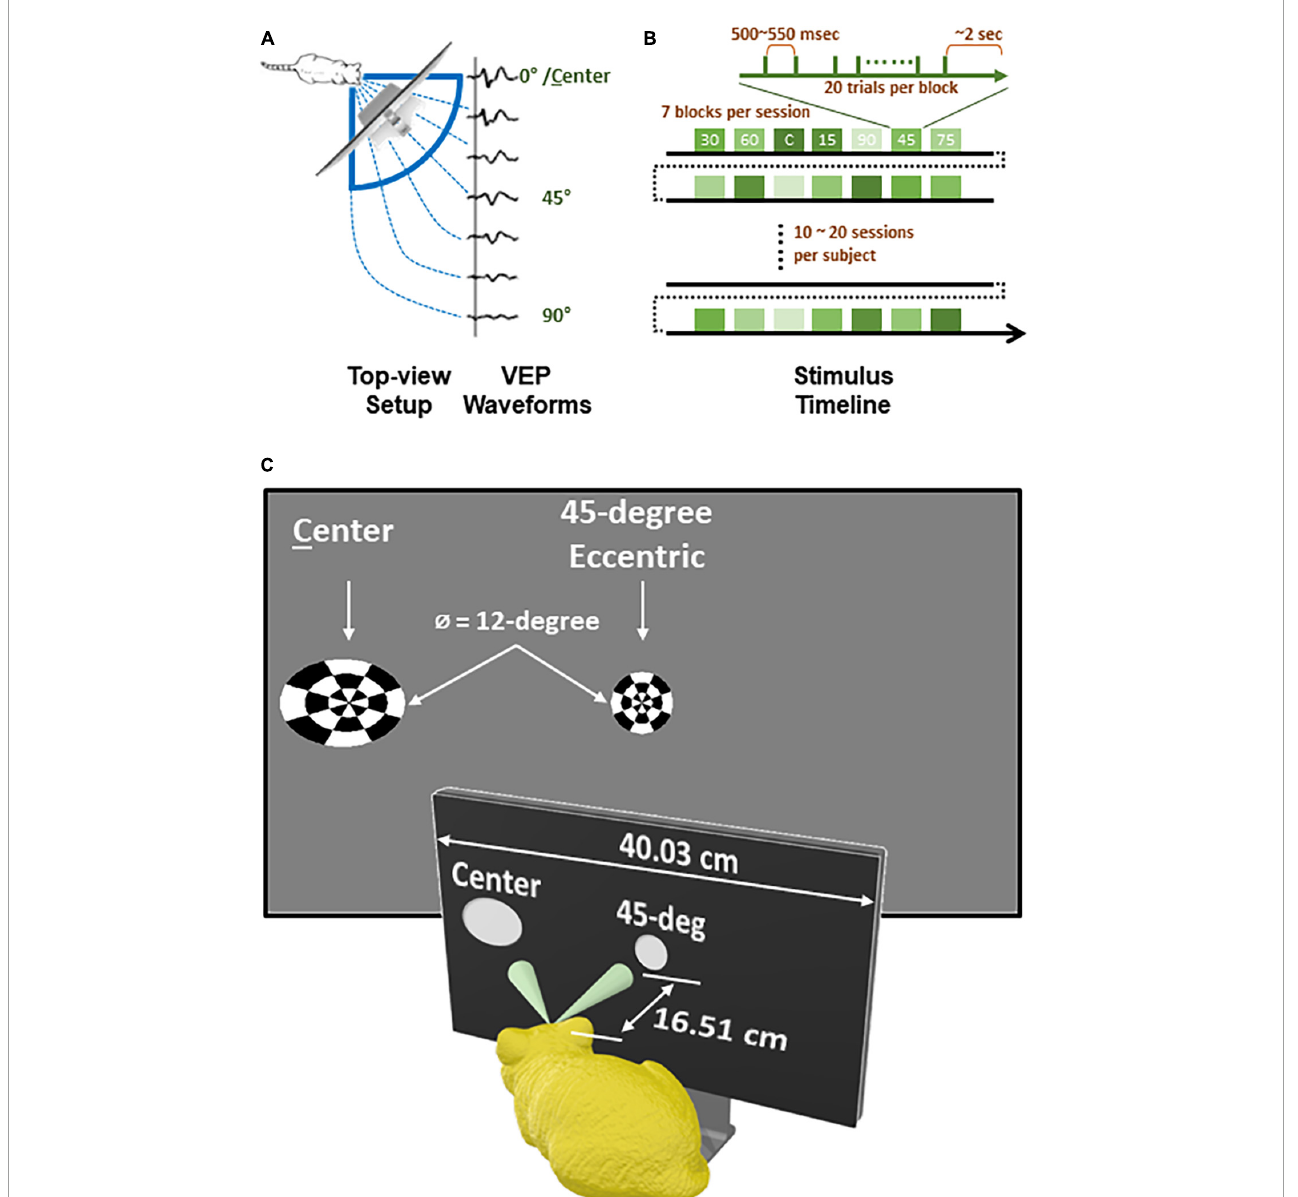
FIGURE1 Experiment design and recording timeline of each subject. (A) A top-view diagram showing how checkerboard stimuli of varying eccentricity were present to animal subject and corresponding VEP waveforms for each eccentricity. (B) A timeline of recording for each subject. (C) Stimuli viewed from subject’s perspective.